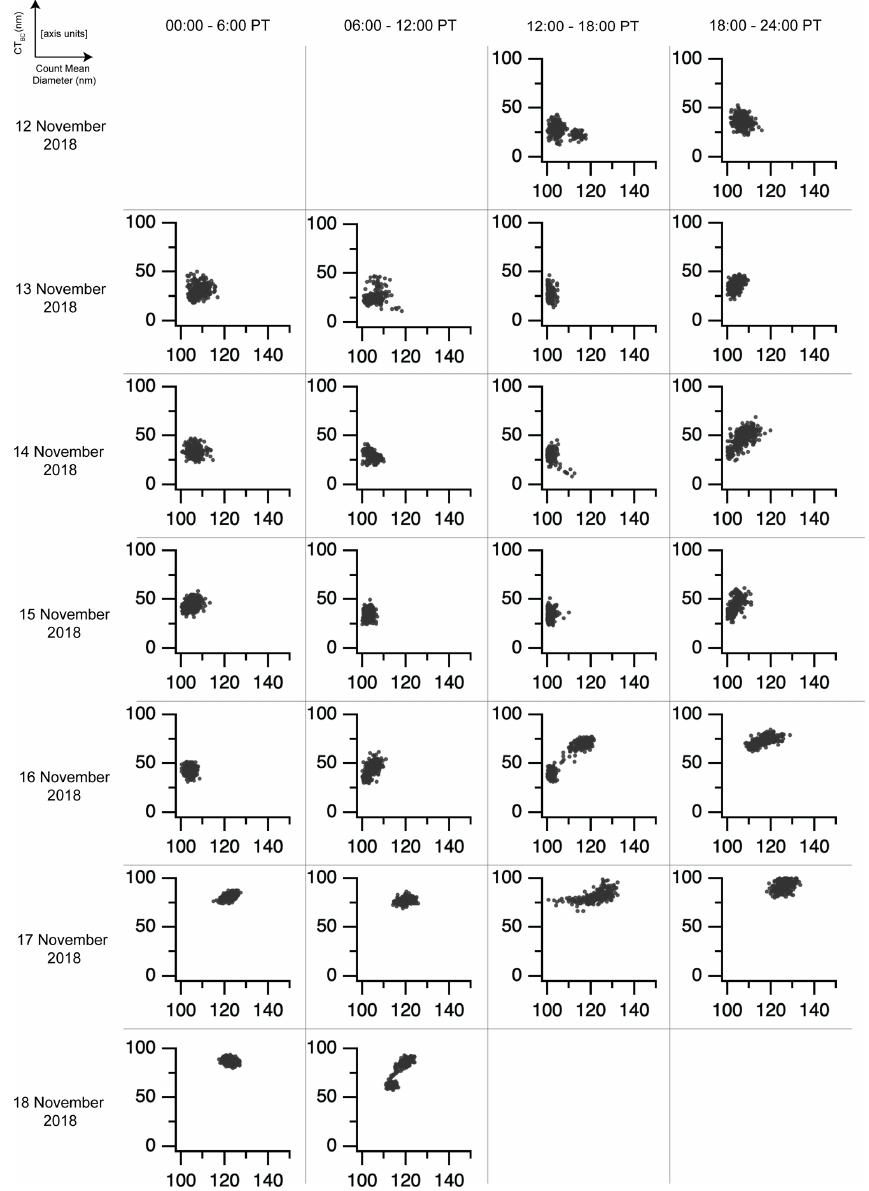
Figure 15. Matrix of scatterplots showing the time evolution of CT BC (nm) and the rBC count mean diameter (nm) for the third campaign (November 2018). Axes labels are shown in the upper left. A scatterplot is shown for each 6h time interval of the day, starting at 00:00PT, and for each day of the campaign. The columns denote the time interval of the day, and the rows denote the day of the campaign. Each point within a plot represents a 1min mean value within that 6h interval for both CT BC and the count mean